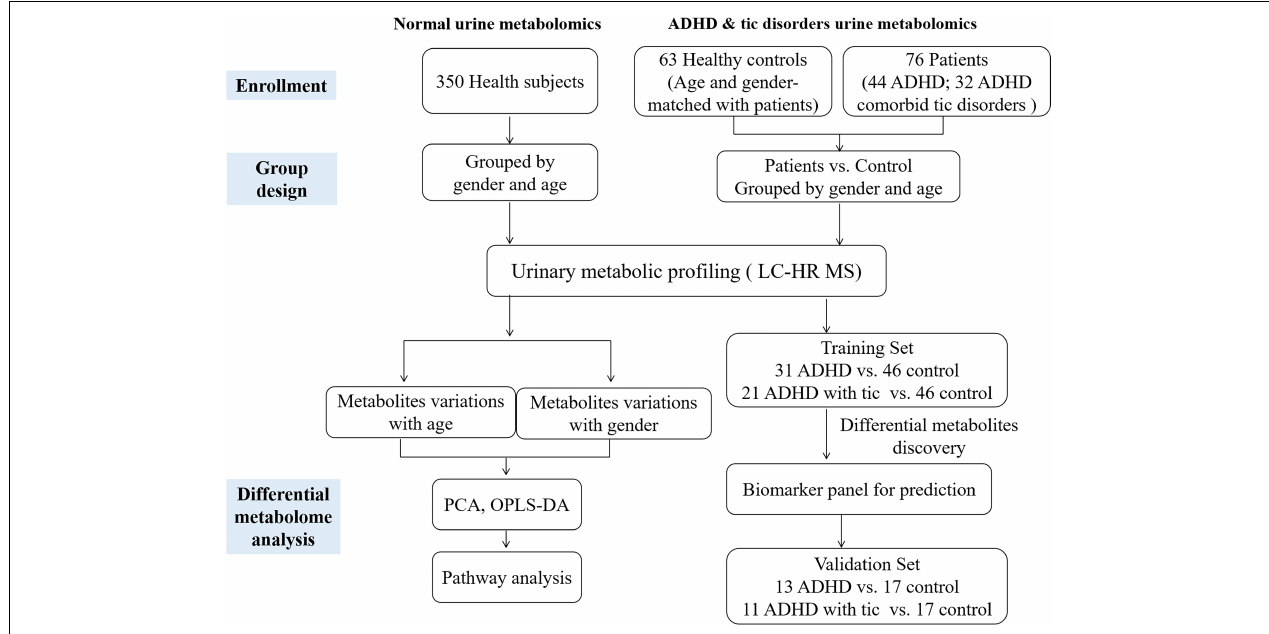
FIGURE 1 | The workflow of this